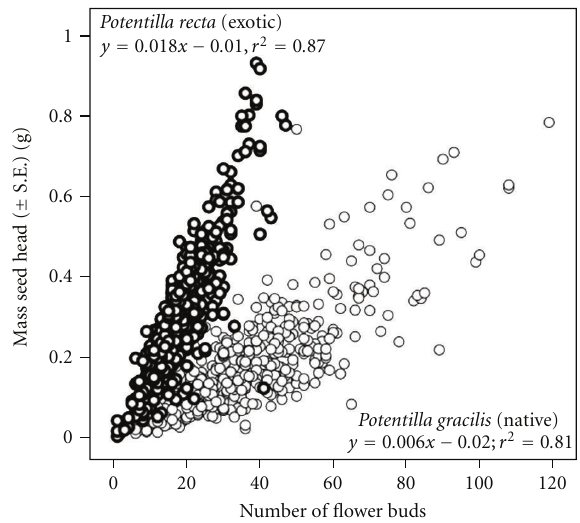
Figure 5: Mass of seed head (grams) as function of the number of buds in a head for Potentilla gracilis (native) and P. recta (invasive), at Rice and Ham sites, northeastern Oregon, June-July, 2003.